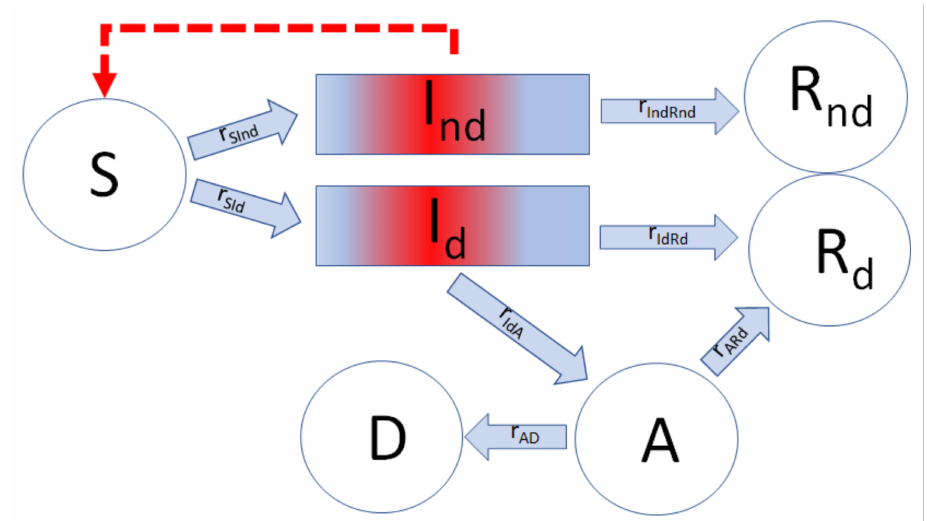
Figure 2. I d is the pool of detected patients; I nd is the pool of non- detected individuals; R nd includes those undiagnosed that have recuperated; R d includes those detected and recuperated; A —the assisted, hospitalized patients; D —the dead; S —those susceptible. The broken lines indicate the action of the U that catalyze the conversion of S into I . The r i represents the flux rate between the different pools. Circles stand for mixed pools, and rectangles for plug-flow